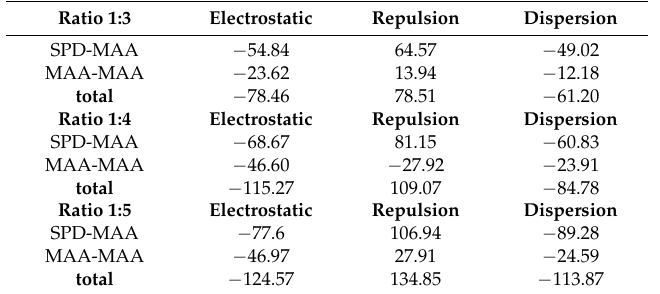
When mapping ρ (r) against the sign ( λ 2 ), there existed a three-dimensional isosurface distribution map of intermolecular weak interactions. Green represents van der Waals interactions, red represents the space repulsive and steric effect, and blue represents the electrostatic interactions and hydrogen bonds. Three-dimensional colored isosurfaces of the non-covalent interactions at the three ratios of SPD–MAA complexes are shown in Figure